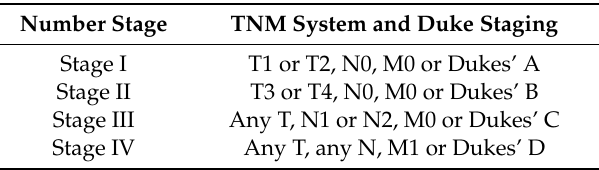
Table 2. Assignment of number